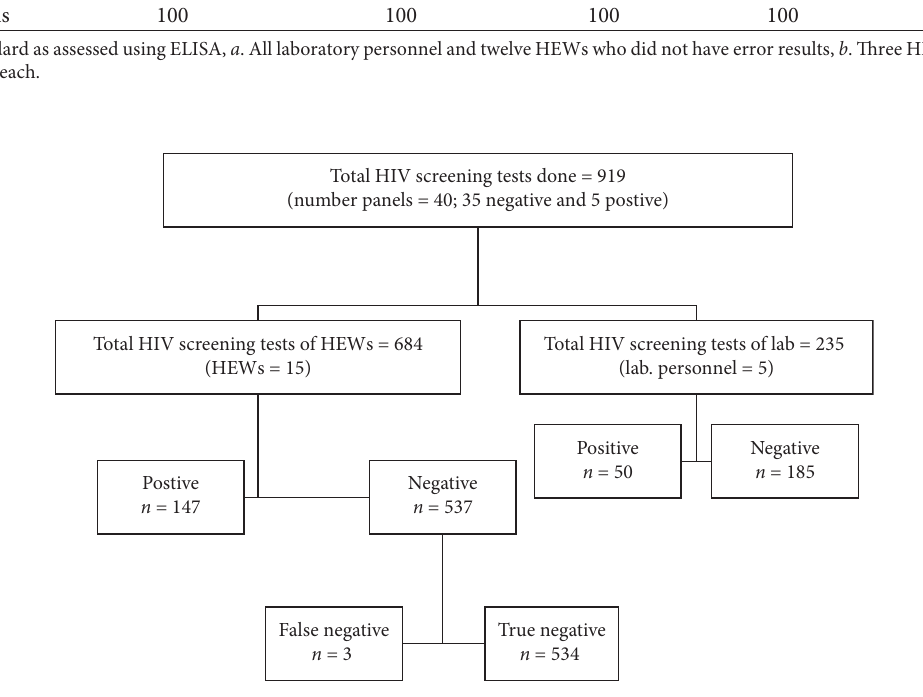
Figure 1: Prototypical STARD diagram to report HIV screening test results of health extension workers and laboratory personnel on pooled